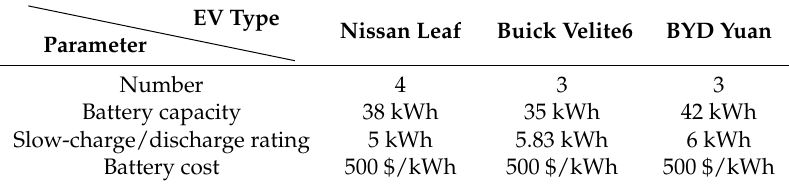
Figure 4. RGs’ forecast outputs, total demand forecast, purchase price from UG, fiducial numbers of arrival/departure EVs. Table 1. EVs’ parameters.